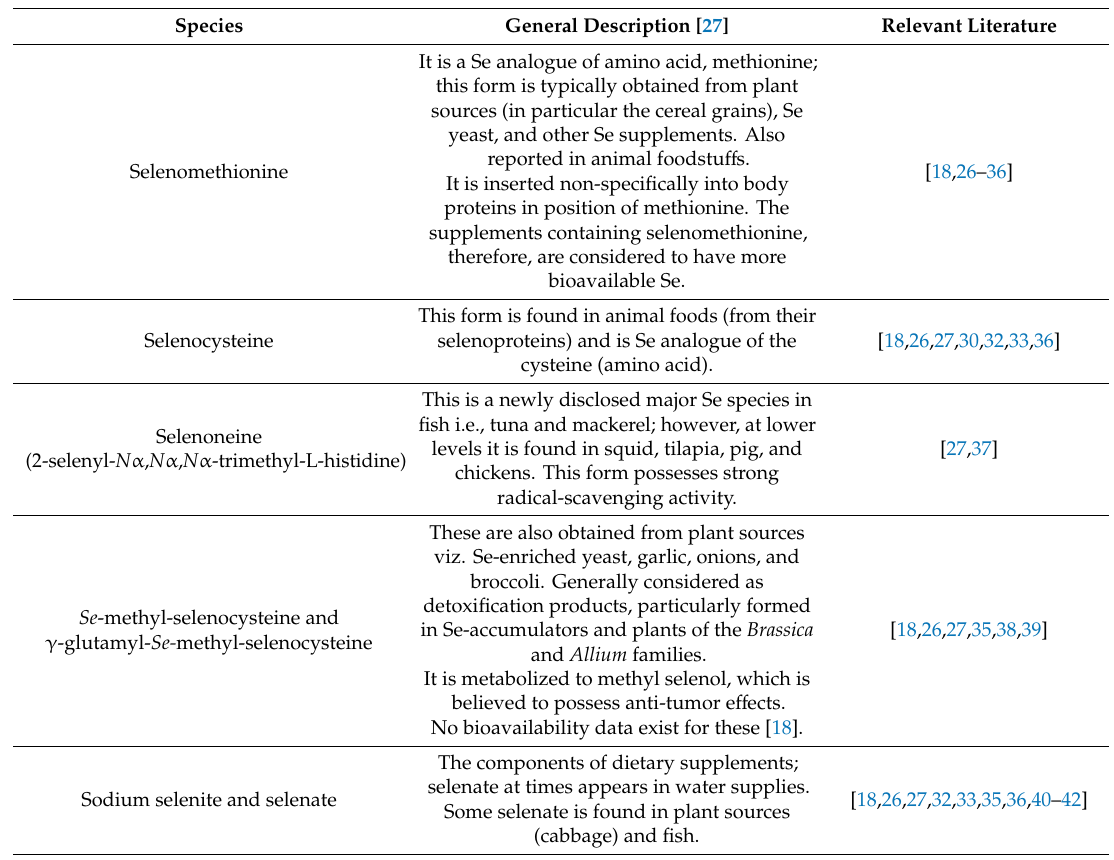
Table 1. Brief description of selenium forms.